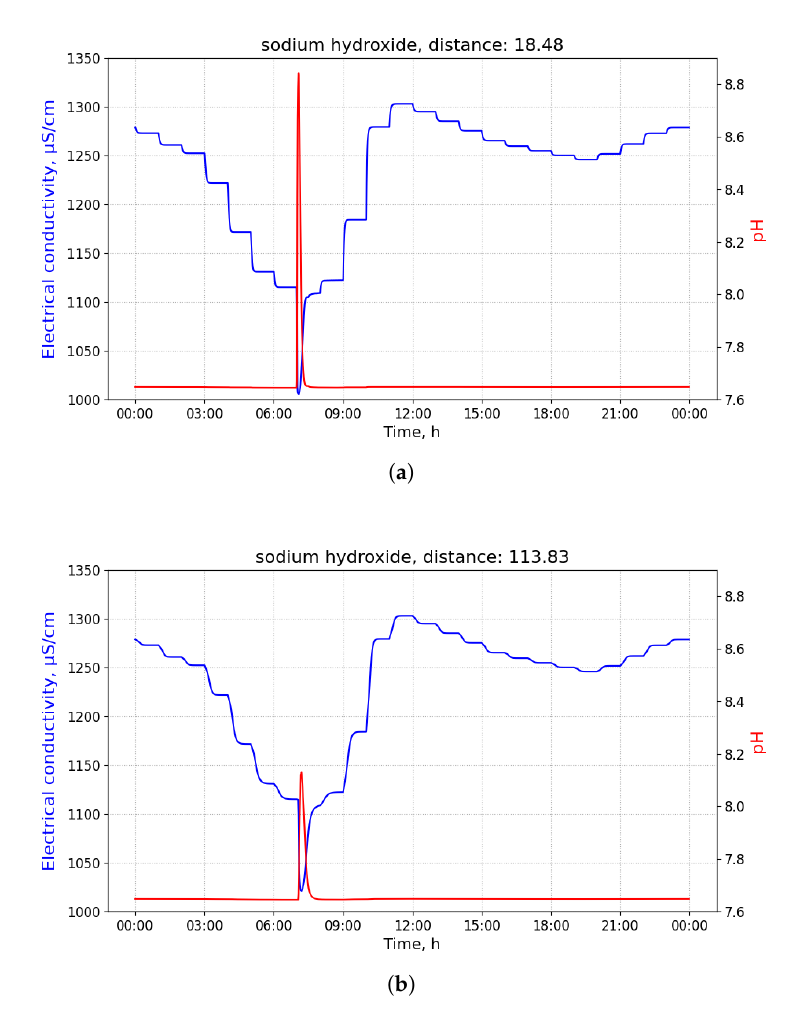
Figure 9. Measurements of pH and electrical conductivity (EC) for the utility network content contaminated with sodium hydroxide conducted at different distances. Values of the horizontal axis represent time of the day. ( a ) Measurements of pH and EC for the utility network content contaminated with sodium hydroxide conducted at the distance of 18.48 m from the contamination source. Measured at the 09 manhole, discharged at the building B18 with 100 L of the pollutant at 3 a.m. ( b ) Measurements of pH and EC for the utility network content contaminated with sodium hydroxide conducted at the distance of 113.83 m from the contamination source. Being measured at the 10 manhole, discharged at the building B18 with 100 L of the pollutant at 3